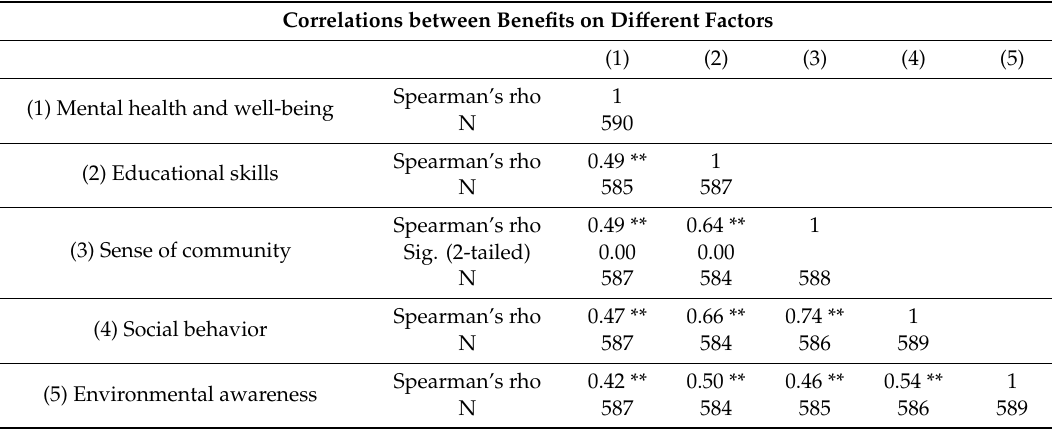
Table 14. Correlations between benefits on di ff erent